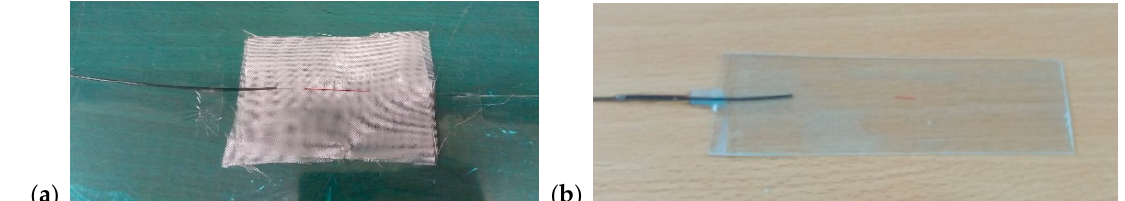
Figure 3. Implementation of the sensor by encapsulating the Bragg grating in fibreglass ( a ); the resulting fibre Bragg grating (FBG) fibreglass sensor ( b ).